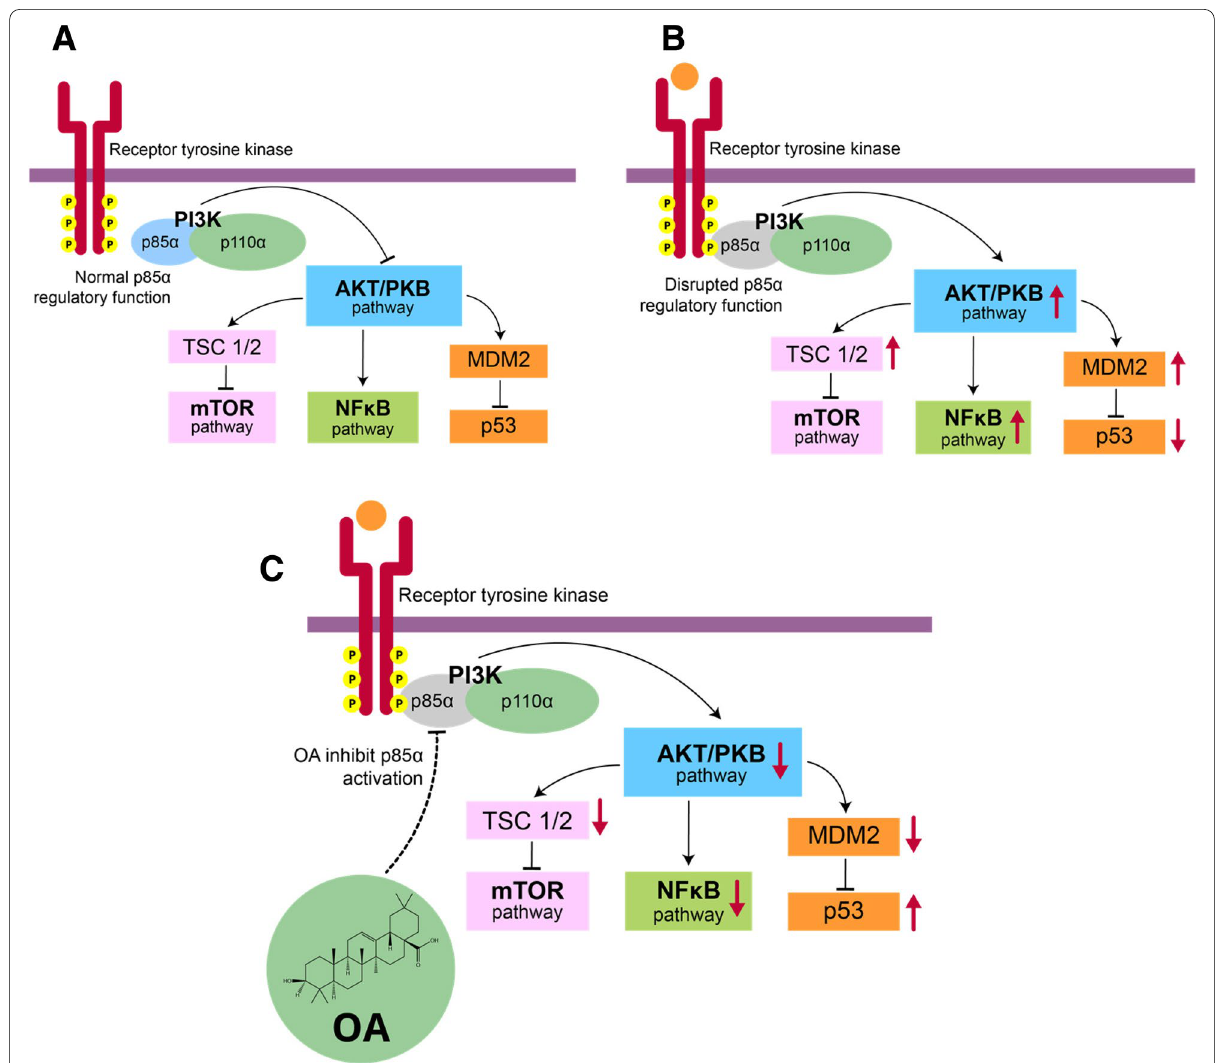
Fig. 6 Proposed molecular mechanism of OA in overcoming tamoxifen resistance. A The regulatory function of p85α is normal. B The regulatory function of p85α is disrupted. C OA reinstates the regulatory function of p85α